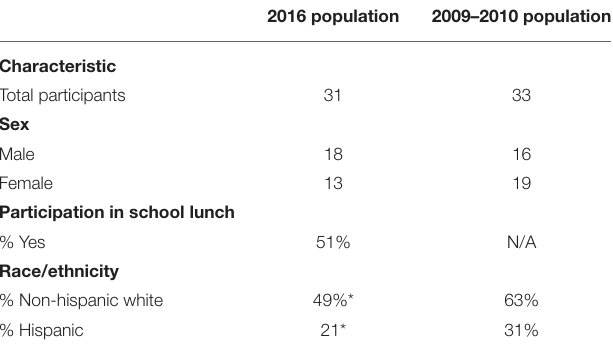
TABLE 1 | Summary of study population